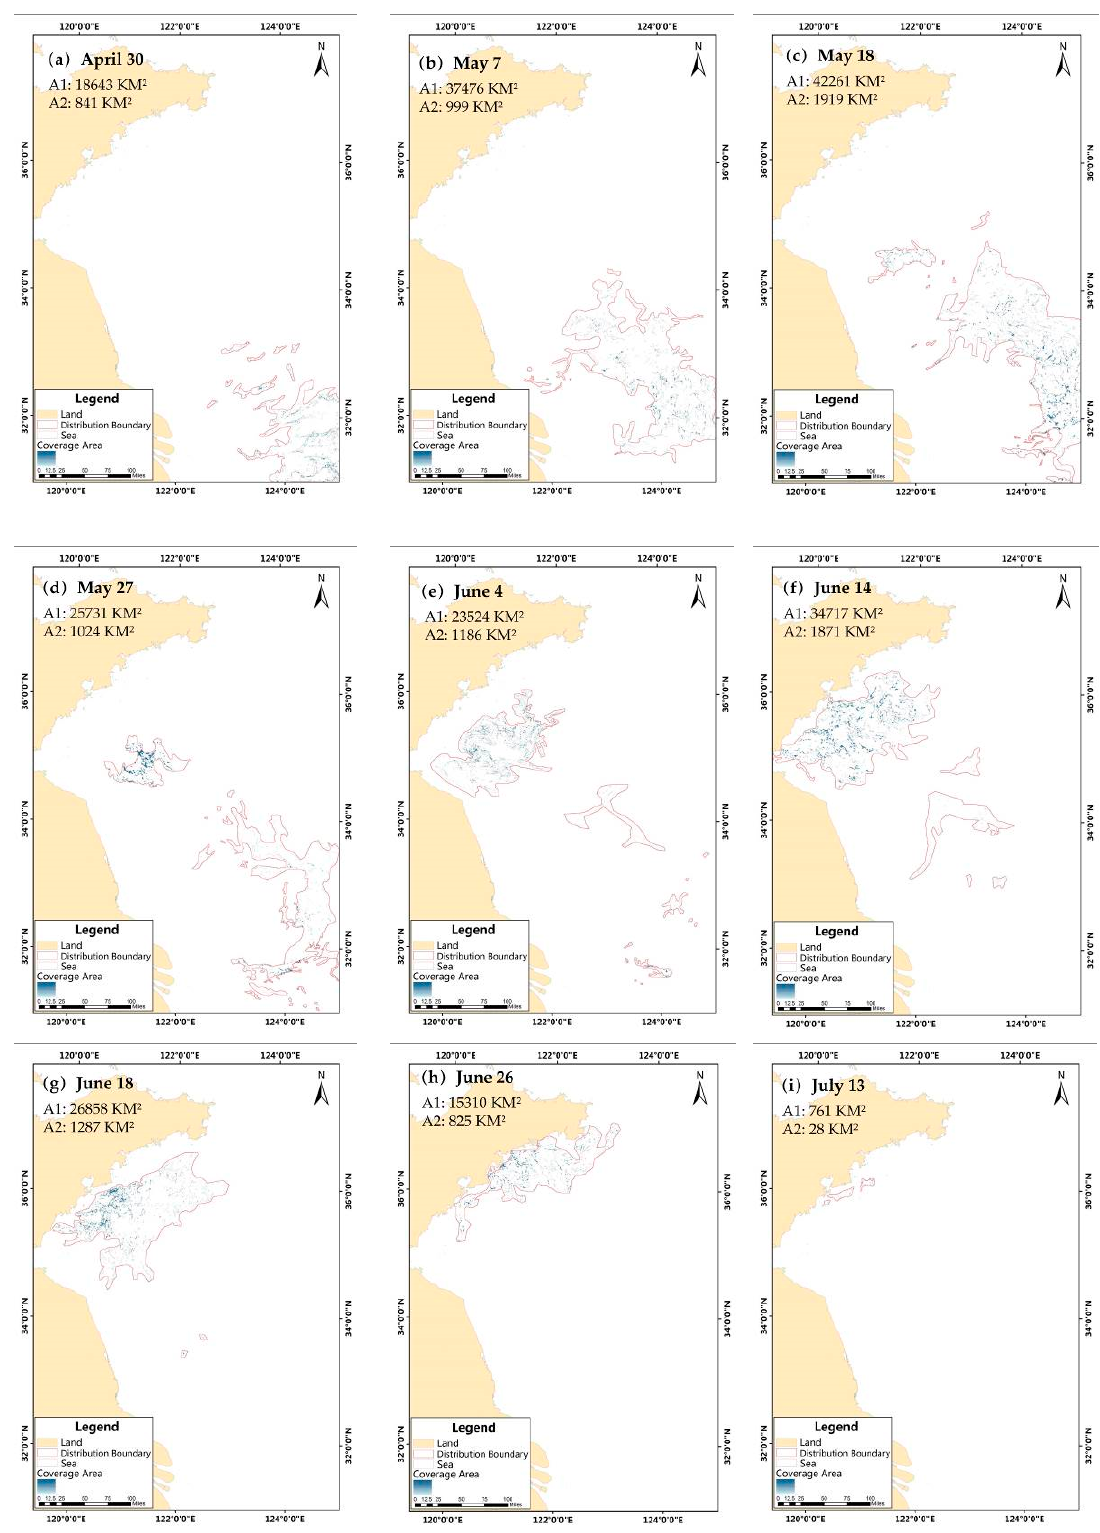
Figure 5. Spatial and temporal distribution of U. prolifera in the Yellow Sea, China in 2017. ( a ) The situation of U. prolifera on April 30. ( b ) The situation of U. prolifera on May 7. ( c ) The situation of U. prolifera on May 18. ( d ) The situation of U. prolifera on May 27. ( e ) The situation of U. prolifera on June 4. ( f ) The situation of U. prolifera on June 14. ( g ) The situation of U. prolifera on June 18. ( h ) The situation of U. prolifera on June 26. ( i ) The situation of U. prolifera on July 13.